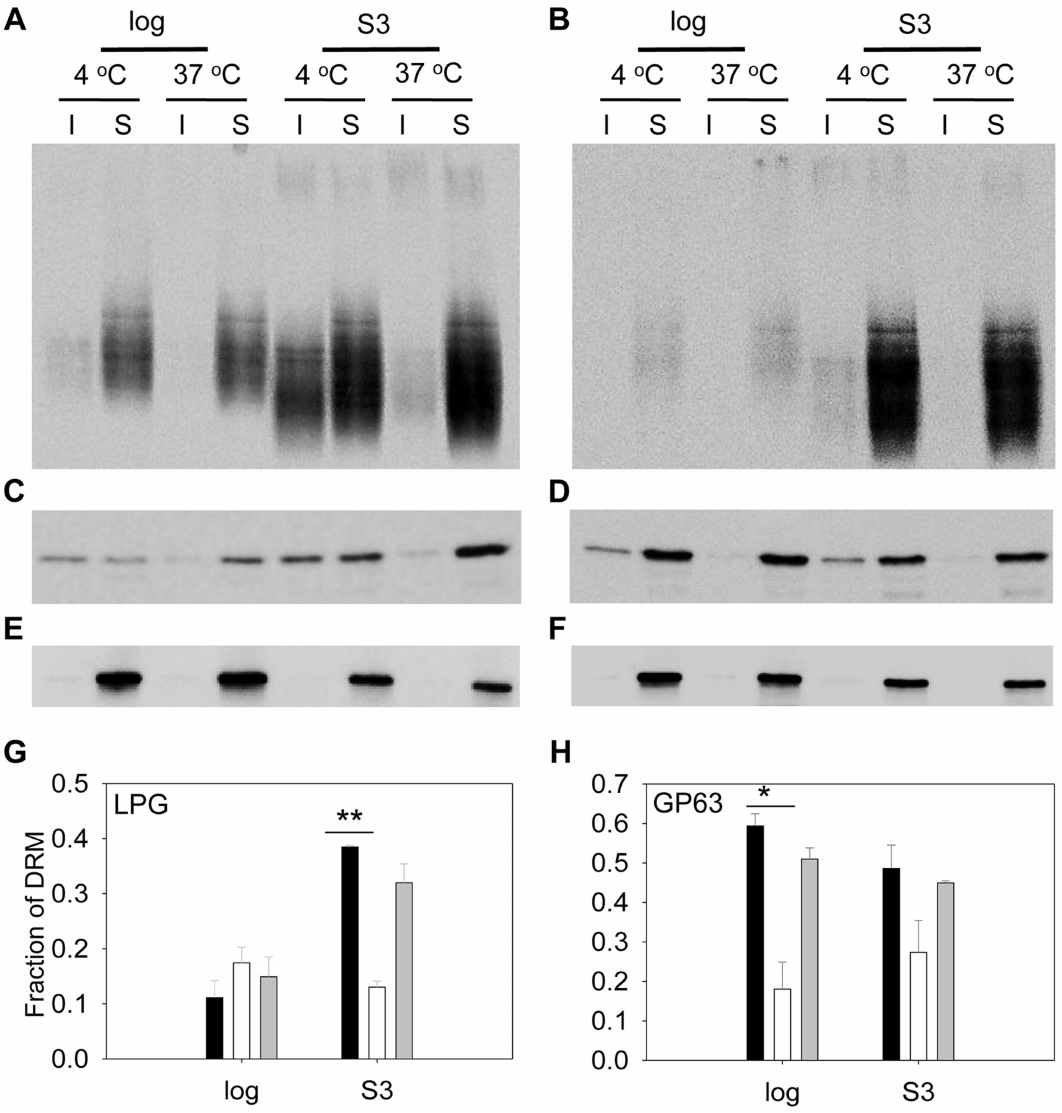
Figure 7. C14dm 2 mutants show reduced LPG and GP63 levels in the detergent resistant membrane (DRM) fractions. ( A – F ) Log phase and day 3 stationary phase cell lysates from WT ( A , C , E ) or c14dm 2 ( B , D , F ) promastigotes were extracted with 1% triton X100 at 4 u C or 37 u C. Both insoluble (I) and soluble (S) materials were analyzed by Western blot, using antibodies against LPG ( A – B ), GP63 ( C – D ) or HSP83 ( E – F ). Fractions of LPG and GP63 in DRM were quantified and summarized in G and H , respectively. Black bars: WT, white bars: c14dm 2 , grey bars: c14dm 2 / + C14DM . Error bars represent standard deviations from 3 experiments (*: p , 0.05, **: p , 0.01).